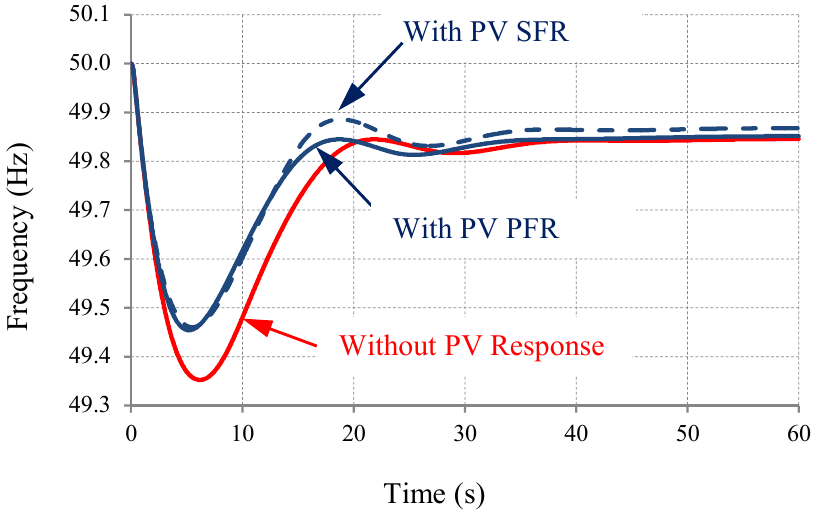
Figure 9. System frequency response to 350 MW generator trip, at minimum residual load point of the year 2021, Case 1.